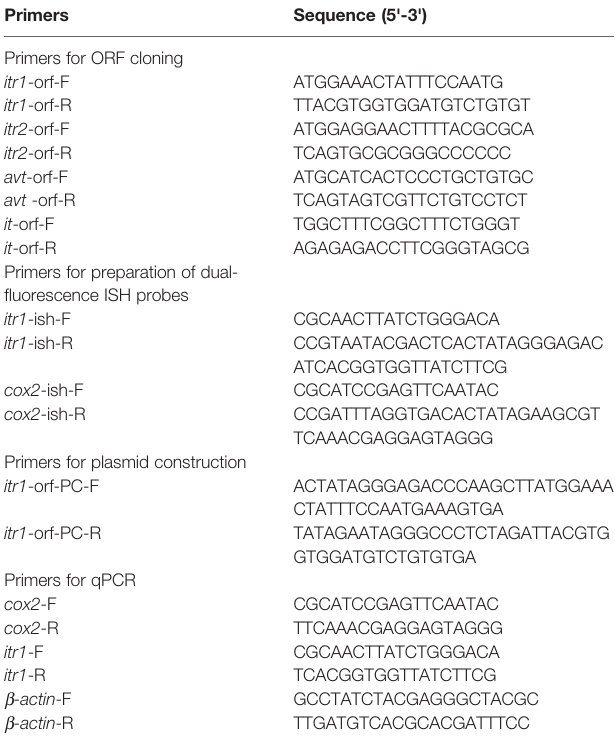
TABLE 1 | Sequences of the primers used for dual- fl uorescence ISH, plasmid construction and qPCR. Primers Sequence